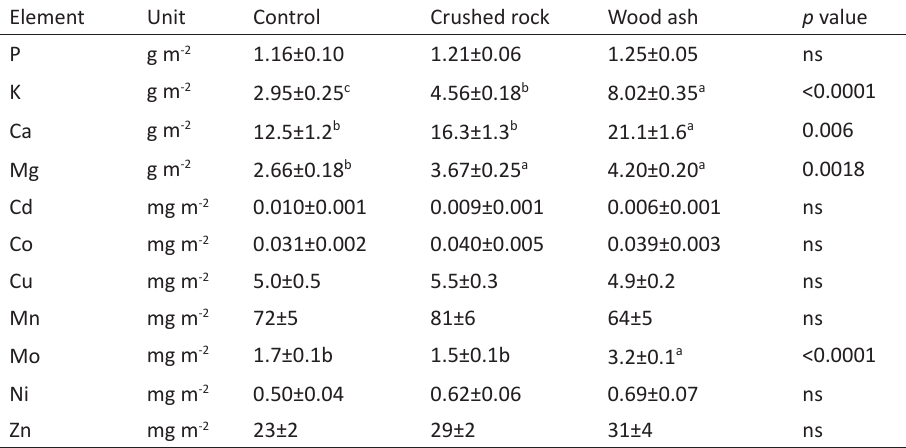
Table 4. Element offtake by harvested shoots of red clover and perennial ryegrass, combined for the two cuts after amendment. Data is given as Least-Squares Means ± SEM. Element Unit Control Crushed rock Wood ash p value P g m -2